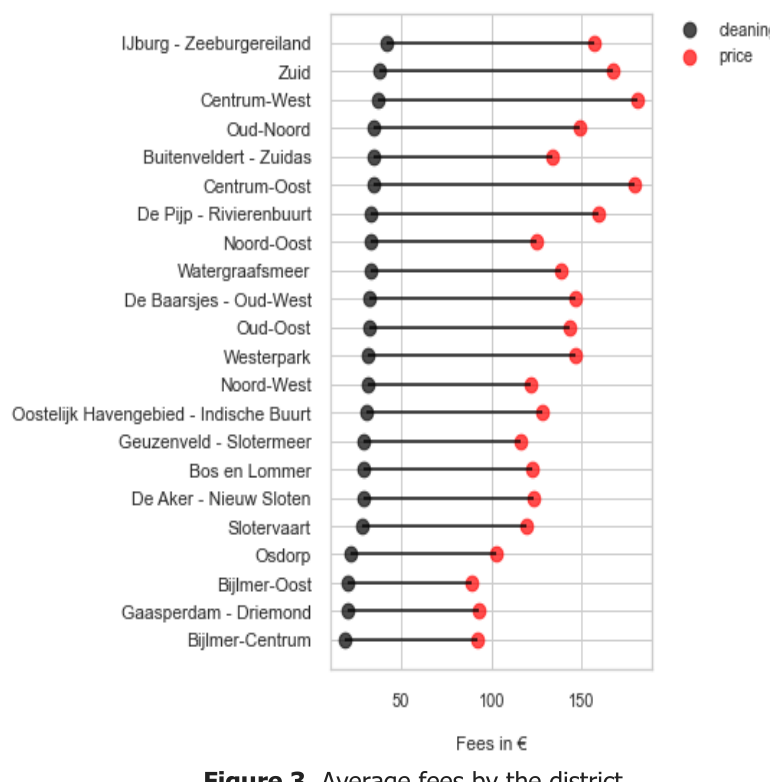
Figure 3 . Average fees by the district